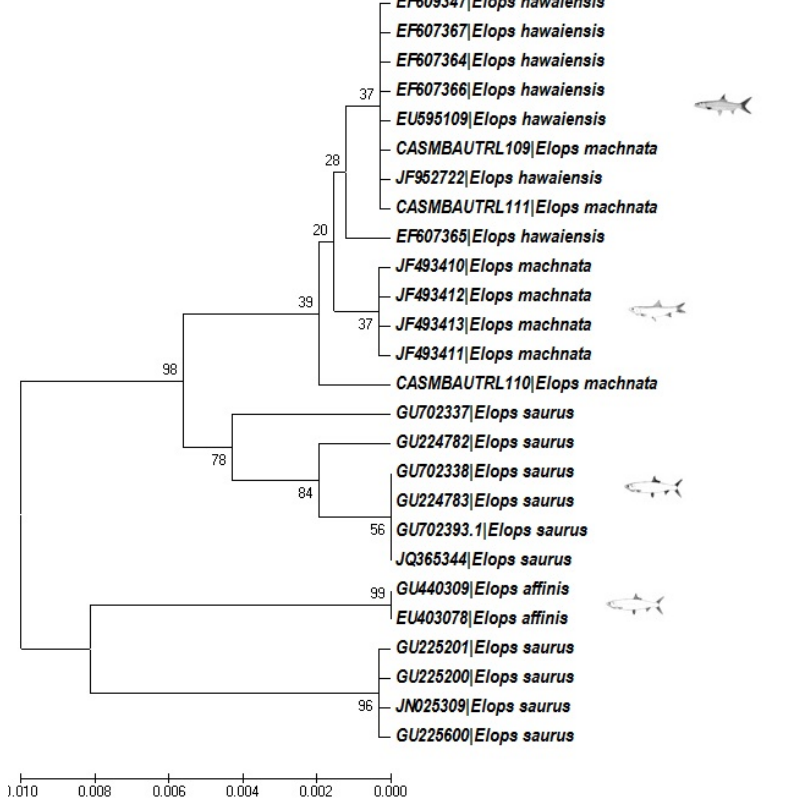
Fig. 3. Neighbour joining tree of Elops species based on CO1 gene